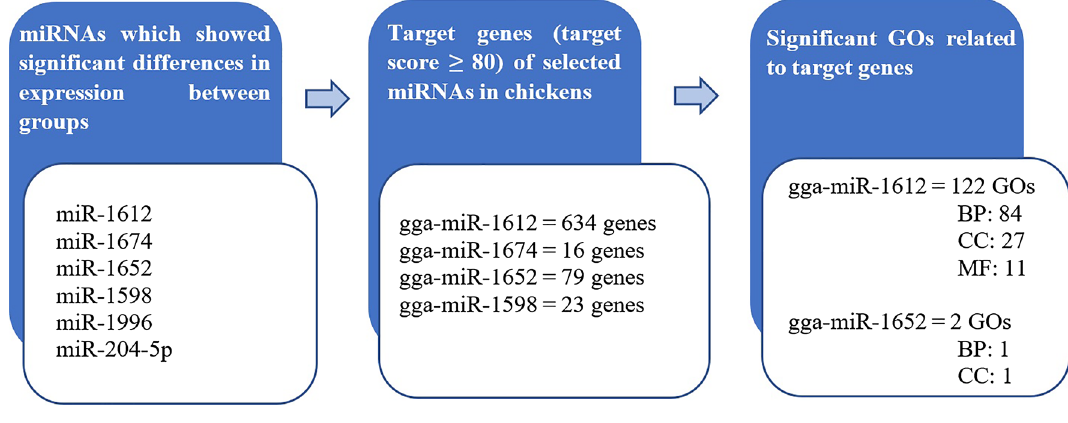
Figure 3. The summary of results from the functional analysis